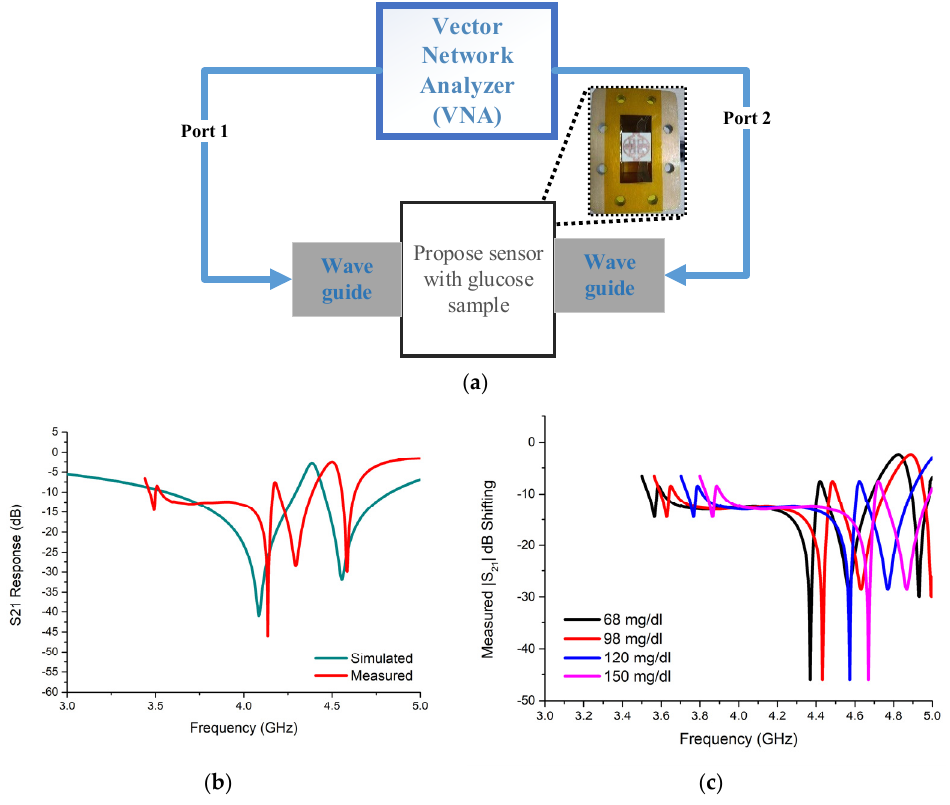
Figure 8. ( a ) Experimental setup for sensing ability measurement. ( b ) S21 response of simulated and measured unit cell glucose sensor; ( c ) Measured S21 resonance variation with different glucose concentrations.